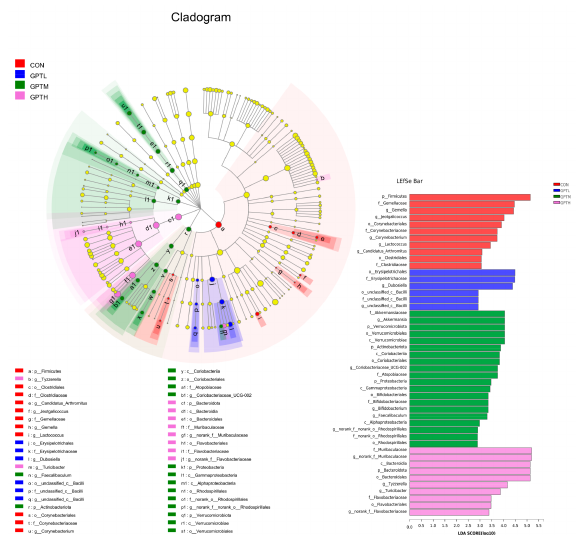
Figure 7. Differences in the gut microbiota between groups using linear discriminant analysis effect size (LEfSe) analysis from phylum level to genus level ( n = 10). For taxa, which were defined as unclassified, no rank, ncultured or Incertae-Sedis, the name of a higher taxon level was added before its taxon abbreviation (p, phylum; c, class; o, order; f, family; g, genus; s, species).